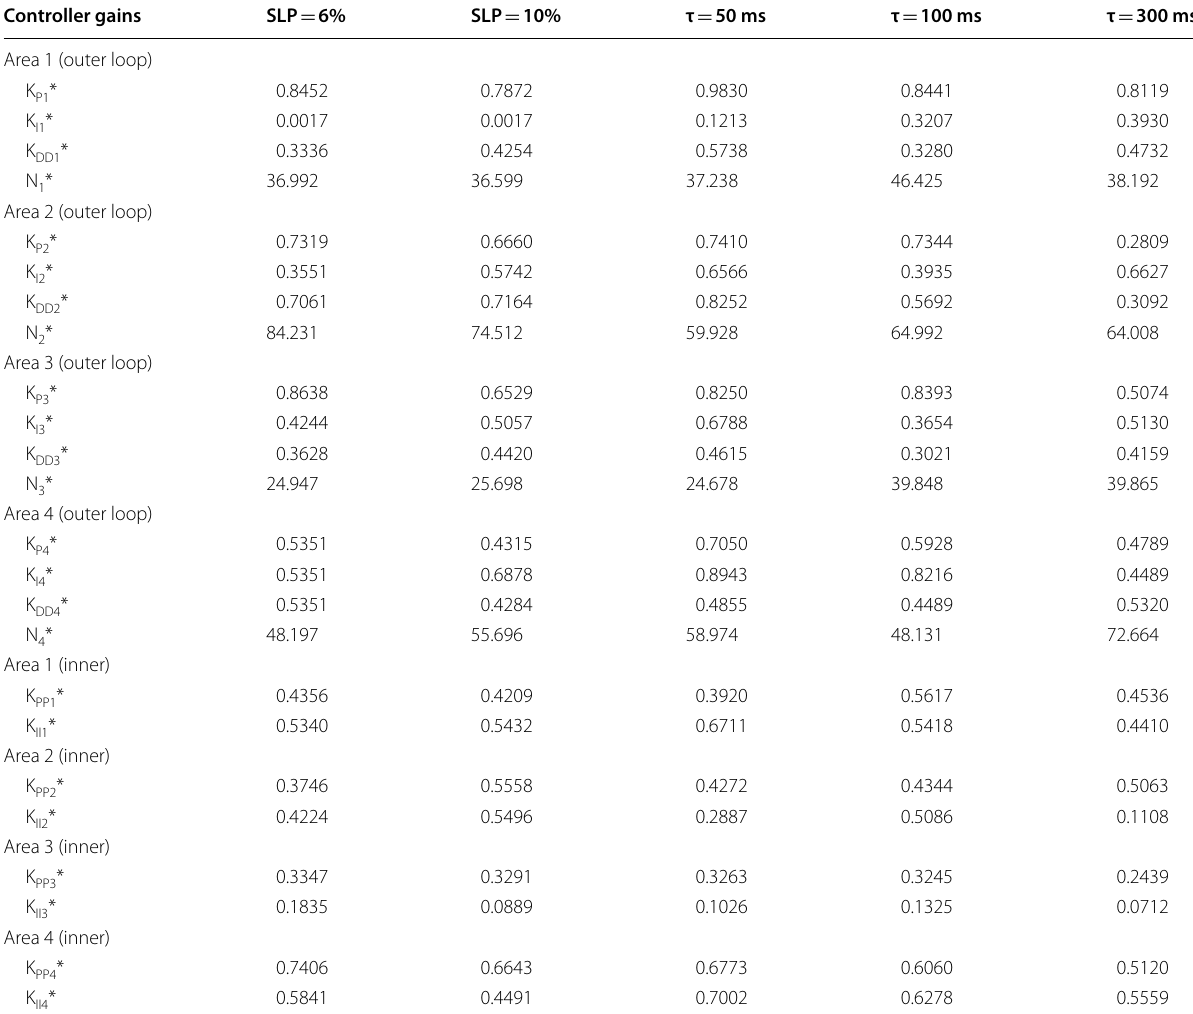
* represents optimum values for the PIDD - PI controller using Harris Hawk Algorithm